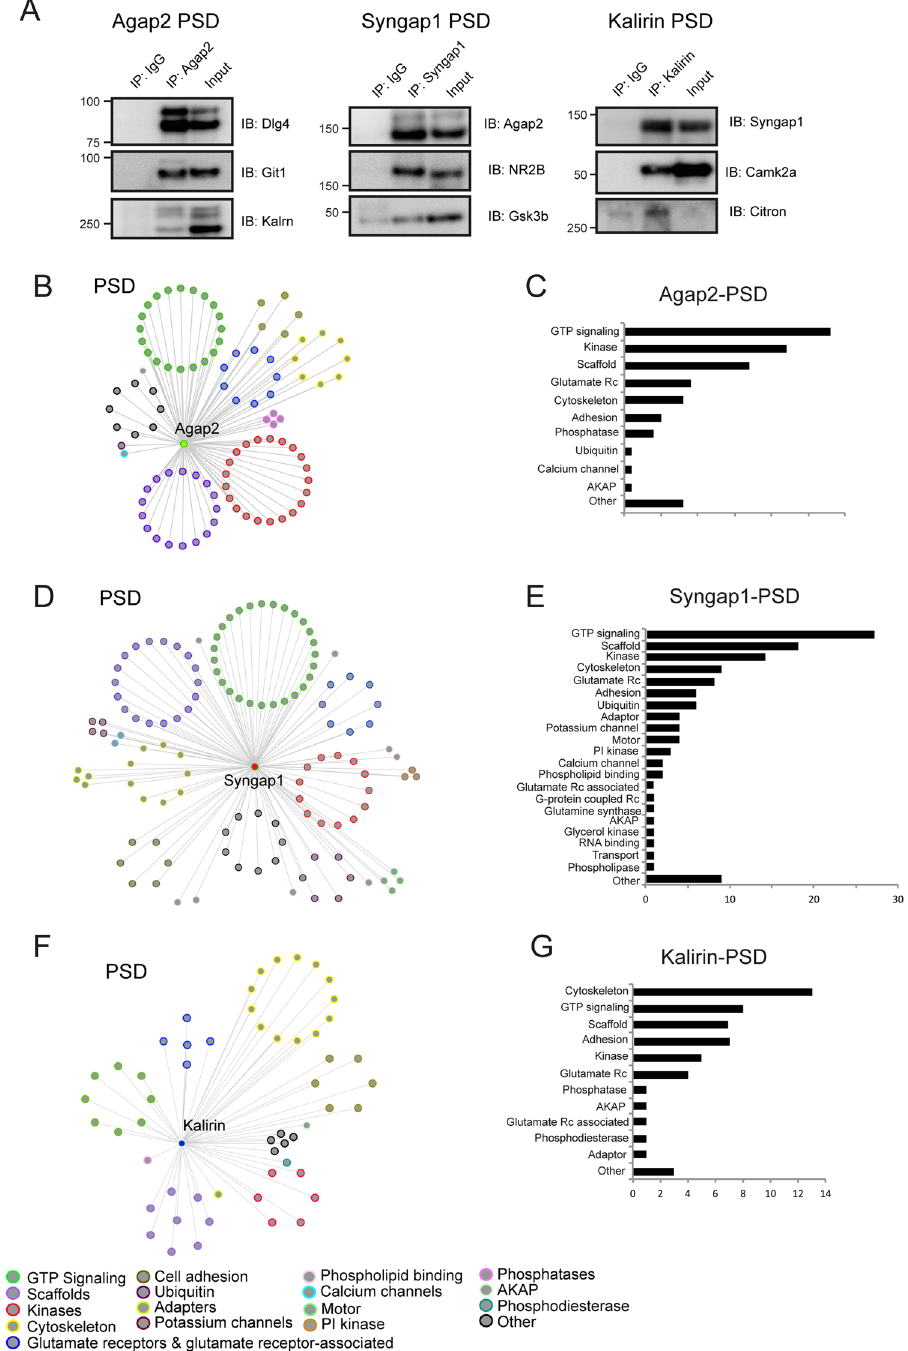
Figure 2. Interactomes of the PSD GAP/GEF proteins, Agap2, Syngap1, and Kalirin. ( A ) Cropped images of immunoprecipitation followed by western blot for interactors of Agap2 (left), Syngap1 (middle), and Kalirin (right) that were identified via HPLC-MS/MS. ( B – G ) Interactome of each respective protein is clustered by protein function which is quantified to right. ( B , C ) Agap2, ( D , E ) Syngap1, ( F , G )